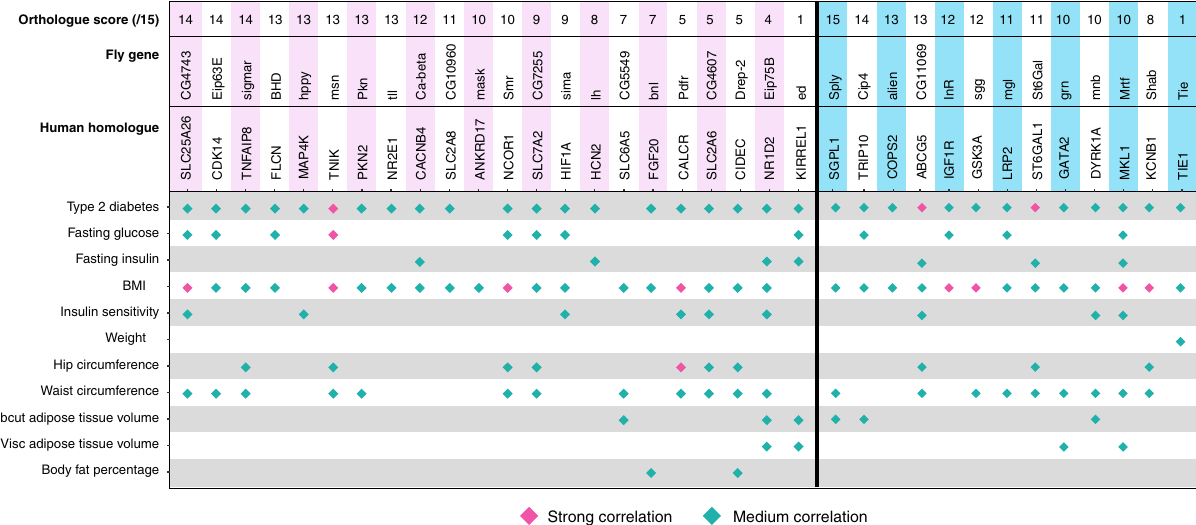
Fig. 8 Comparison of hits to human SNP data associated to diabetes phenotypes. The majority of the human homologues of the identi fi ed hits are associated with T2D related traits. T2D knowledge portal